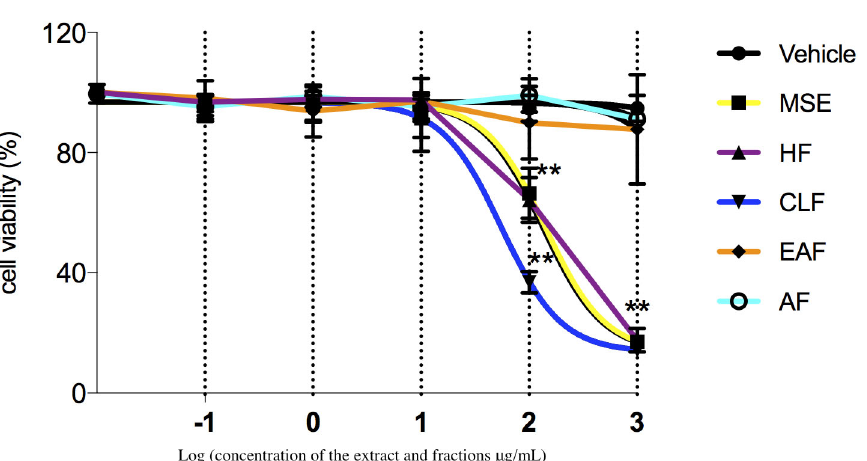
Fig 3. Effect of MSE and fractions on cell viability. Log dose response of MSE, HF, EAF, and AF on RAW 264.7 cells. Significant difference between fractions at the indicated dose (p < 0.05). ** Significant difference between IC50 values (p < 0.05). Data were expressed as mean ± SD, n =